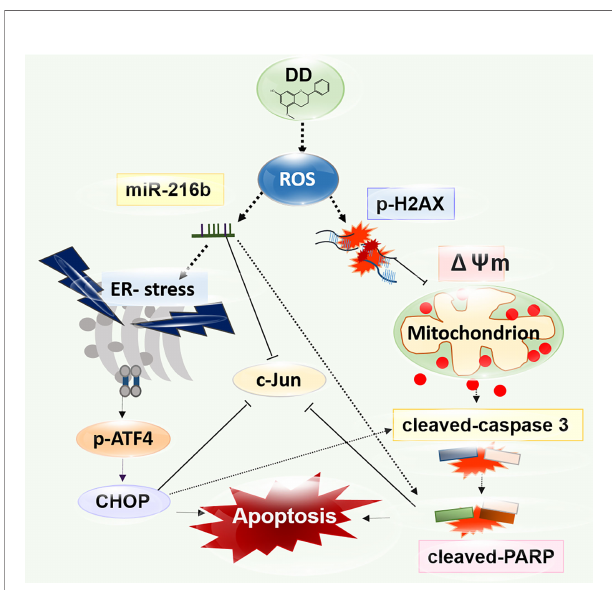
FIGURE 7 | A diagram of the anticancer effect of Daemonorops draco Blume (DD) research strategy. DD signi fi cantly promoted mitochondria-mediated caspase activation and endoplasmic reticulum stress-related apoptosis pathway involved in reactive oxygen species generation, leading to apoptosis due to DNA damage in AML cells. DD treatment signi fi cantly showed anticancer effects on AML cells by signi fi cantly inhibiting c-Jun, leading to apoptosis via the regulation of